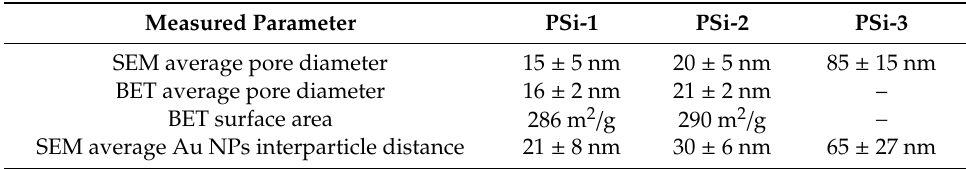
Table 1. The average pore diameter of PSi films obtained from SEM and BET analysis, values of the BET surface area of the samples and from SEM estimated Au NPs interparticle distance.